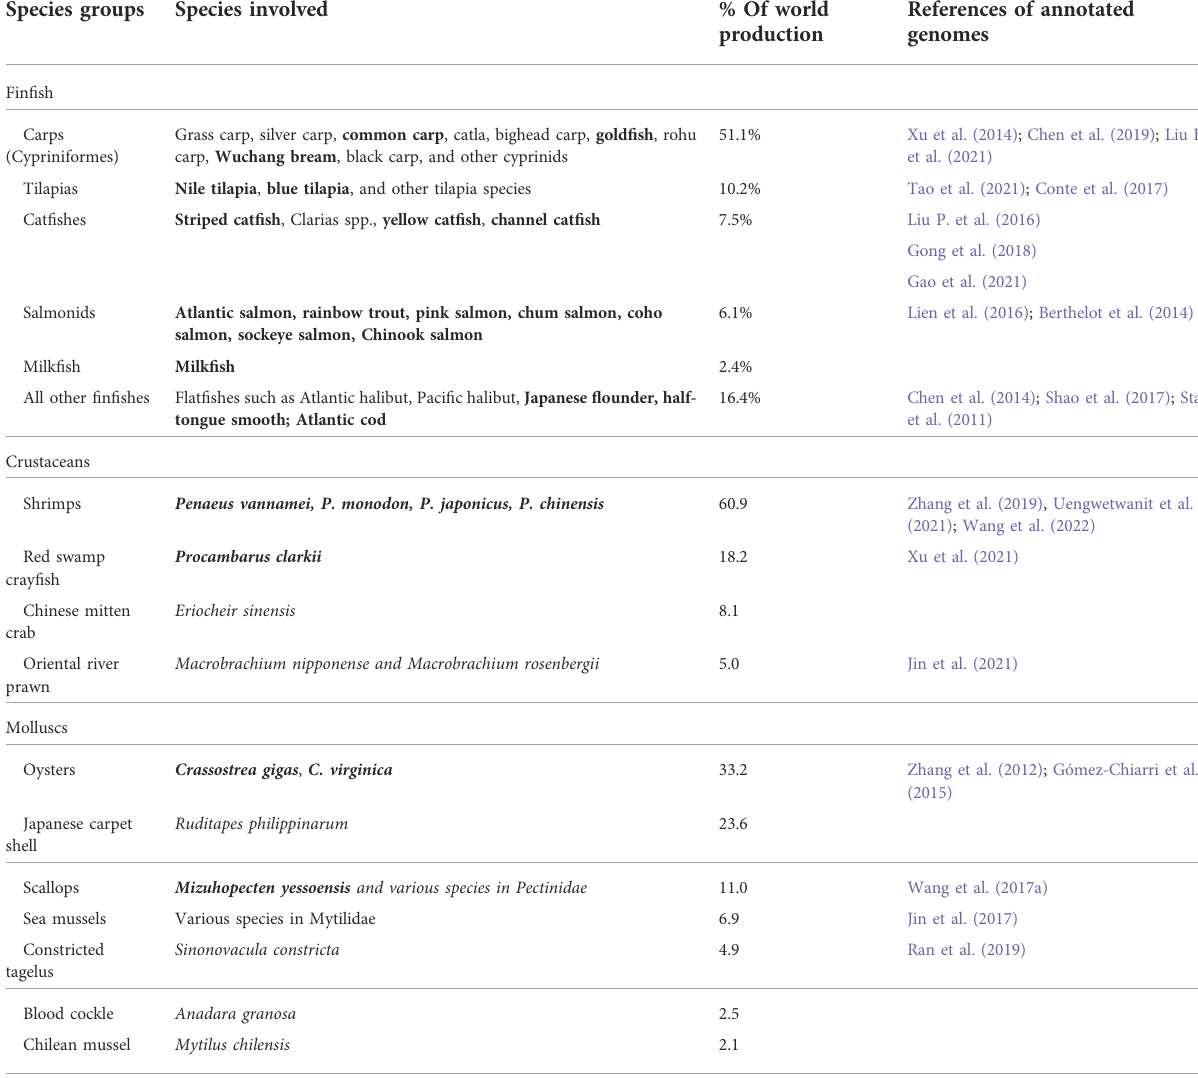
TABLE 1 Major aquaculture species of fi n fi sh, crustacean, and molluscs in the world and their whole genome sequence resources. Species